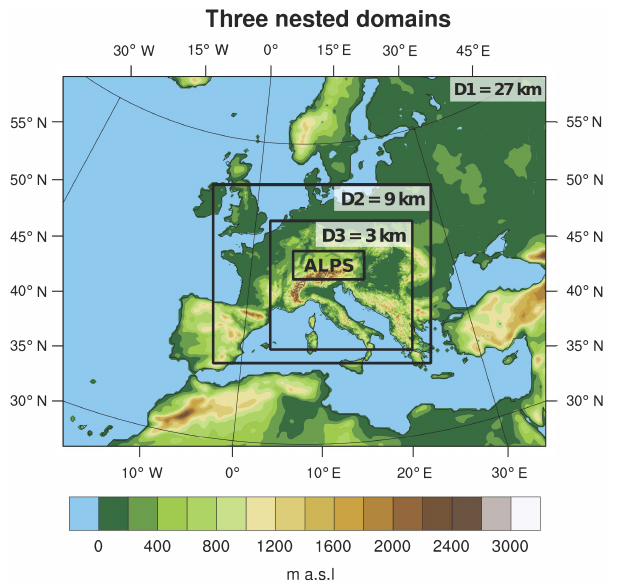
Figure 1. The three nested domains (D1 to D3) with their actual resolution are depicted as black boxes. The box labelled “Alps” de- notes the area used for measuring the precipitation intensity of the Vb events. The shading shows the topographical elevation imple- mented in the simulations in metres above sea